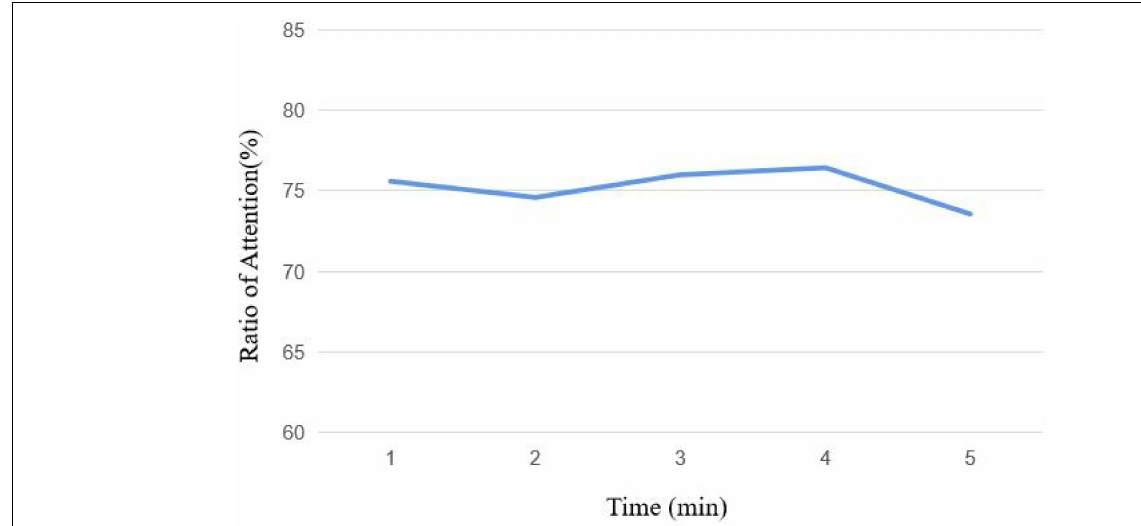
FIGURE 13 | Attention curve of course 3.